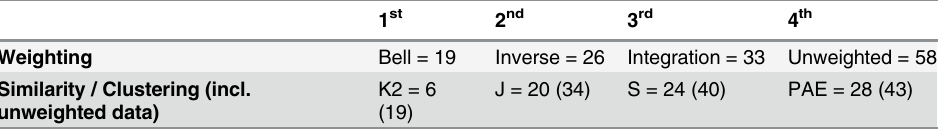
Table 4. The summed ranking of the different weighting techniques and similarity / clustering tech- niques employed. 1 st 2 nd 3 rd 4 th Weighting Bell = 19 Inverse = 26 Integration = 33 Unweighted = 58 Similarity / Clustering (incl. K2 = 6 J = 20 (34) S = 24 (40) PAE = 28 (43) unweighted data) (19) Summed ranking values were calculated from Table 3. Lower scores (summed placements) indicates a higher ranking. J = Jaccard, K2 = Kulczinsky2, S =